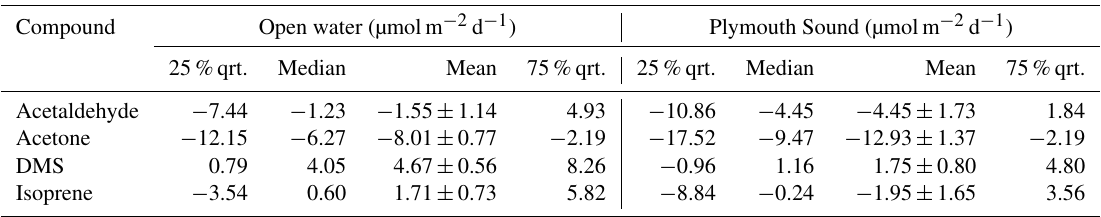
Table 1. Eddy covariance flux measurements over the entire campaign. Errors indicate standard errors (SEs) with n = 135 and n = 40 bins (1h averages) for the open-water and Plymouth Sound sectors respectively. Also included are the quartiles (qrt). Compound Open water (µmolm − 2 d − 1 ) Plymouth Sound (µmolm − 2 d − 1 ) 25%qrt. Median